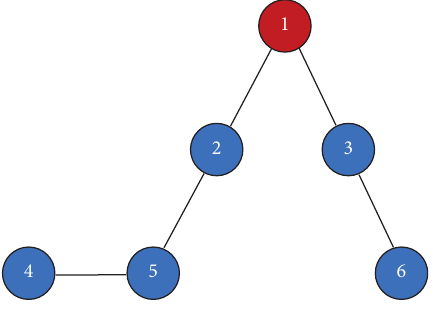
Figure 2: Topology of communication graph for CAUS. Table 1: The initial states and the desired states of CAUS.